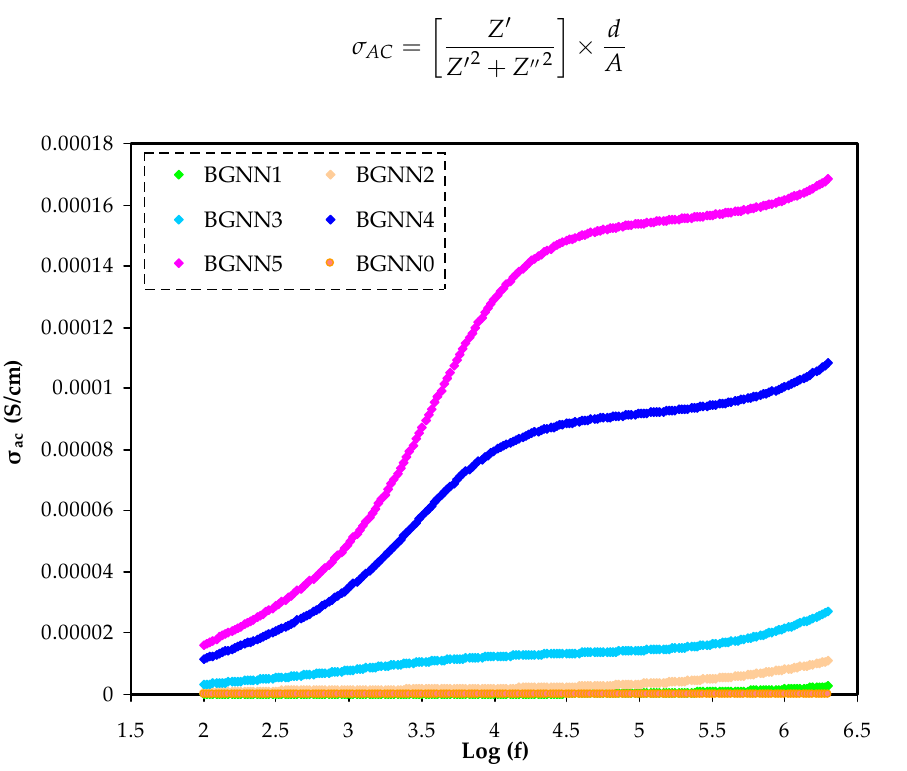
Figure 9. The σ ac spectra for the NBG electrolyte systems.